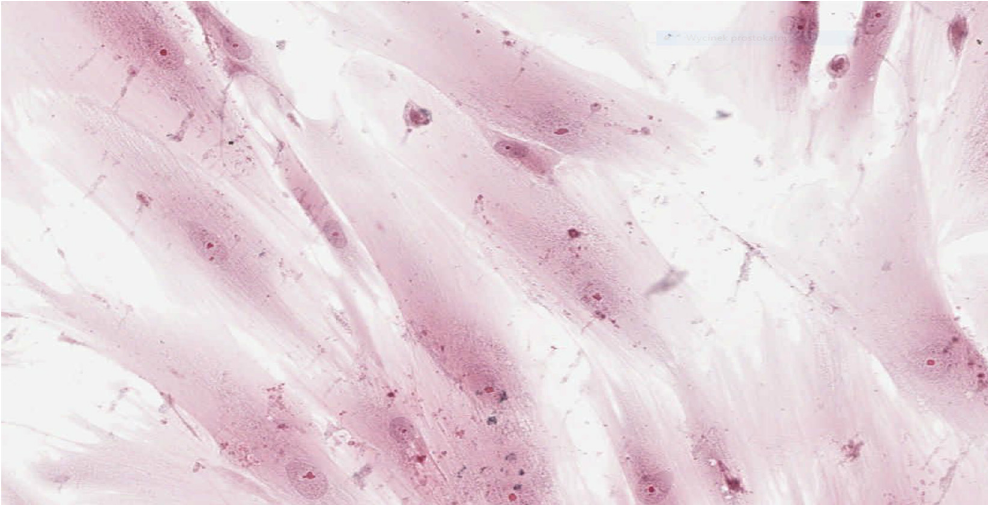
Figure 6. Image of cells cultured on medium with PROTEFIX; 200 ×